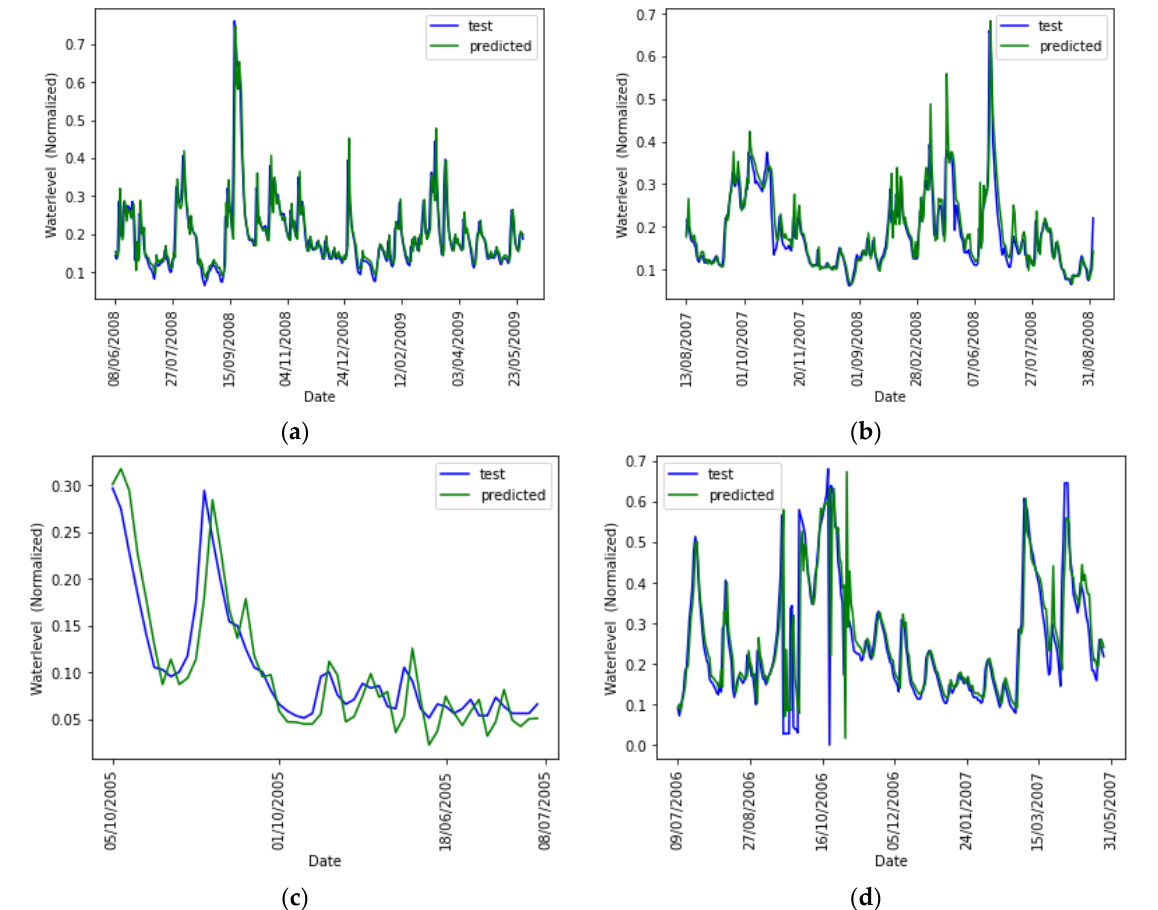
Figure 7. Actual vs predicted water level comparison for LSTM-based model of ( a ) Kimbulawala, Figure 7. Actual vs. predicted water level comparison for LSTM-based model of ( a ) Kimbulawala, ( b ) Kotte Canal, ( c ) Kotte North, and ( d ) Parliament Lake. ( b ) Kotte Canal, ( c ) Kotte North, and ( d ) Parliament